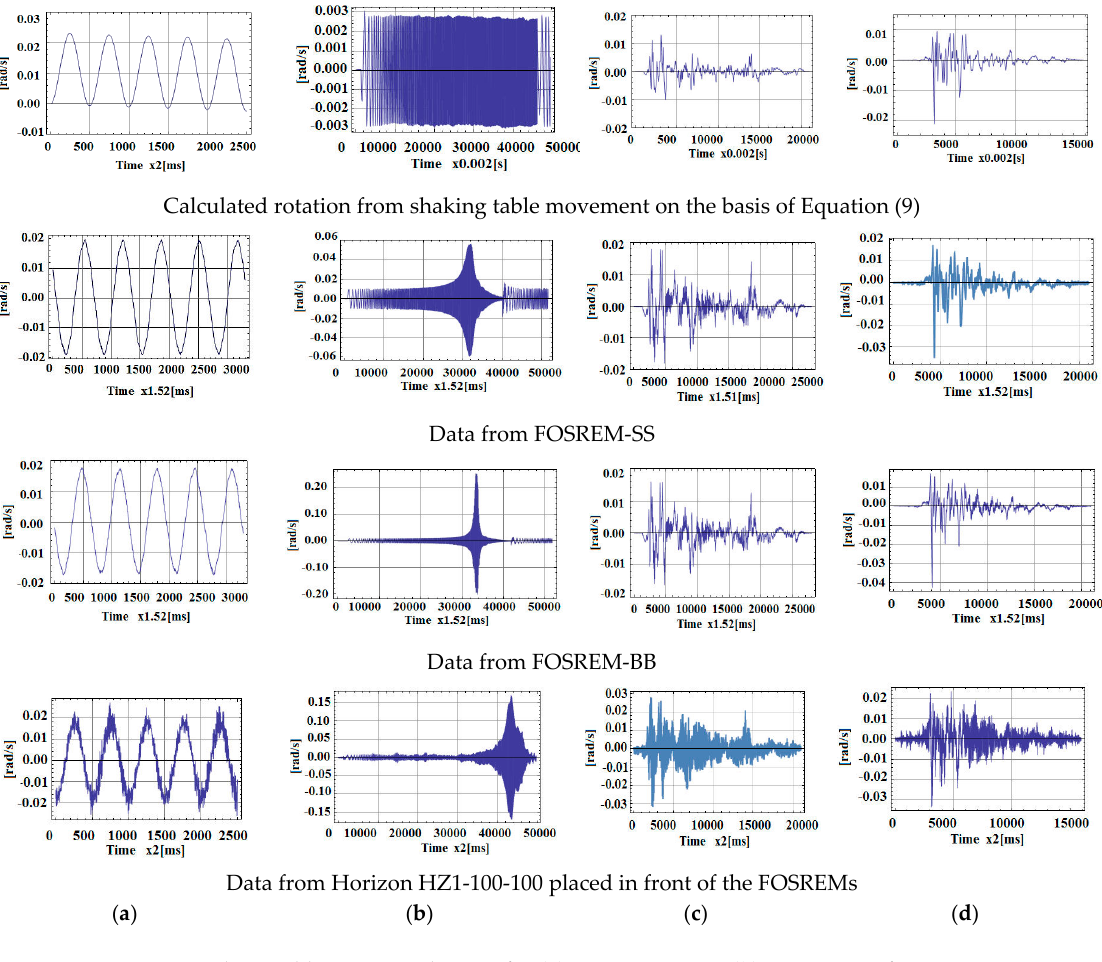
Figure 12. Data obtained by various devices for ( a ) sine excitation; ( b ) sweep sine from 0.25 Hz to 10 Hz; ( c ) El Centro earthquake; ( d ) Loma Prieta earthquake.